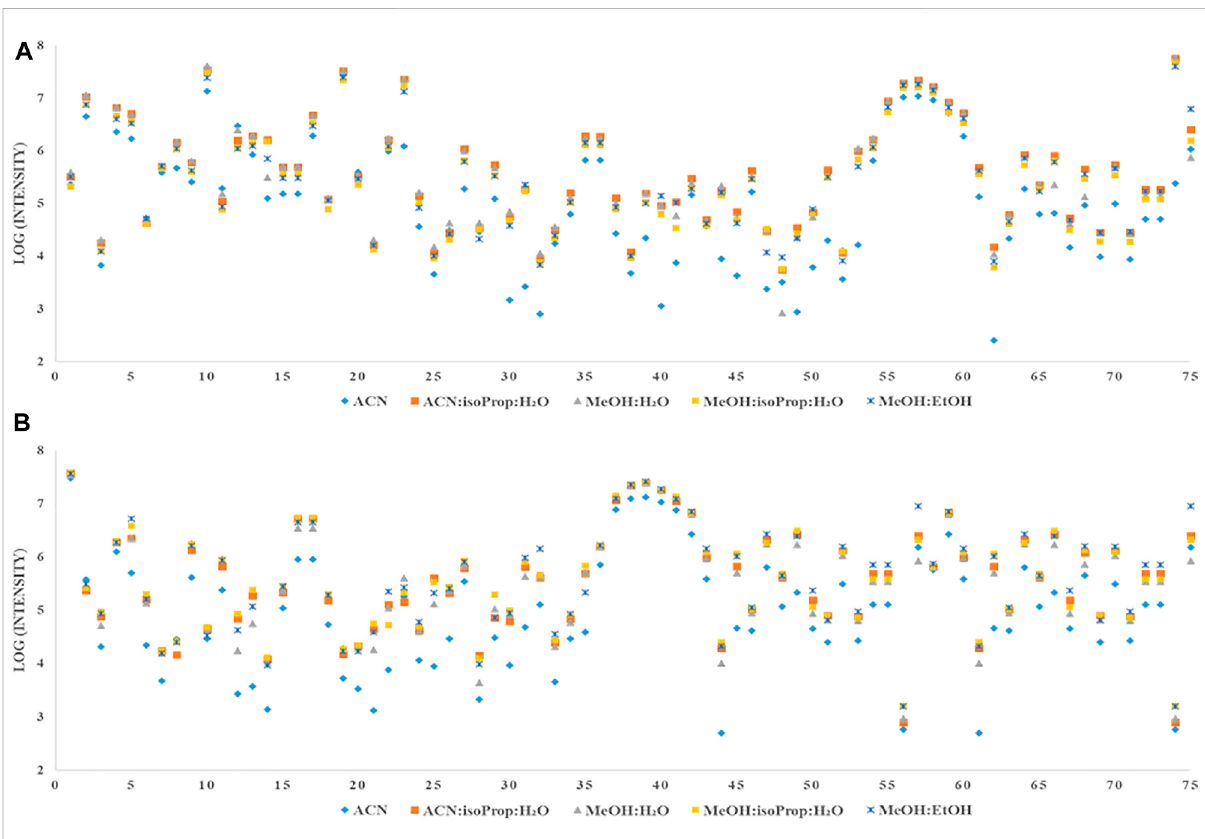
FIGURE 2 Comparison of intensity of all detected metabolites extracted with different solvents from plasma (A) or serum (B)